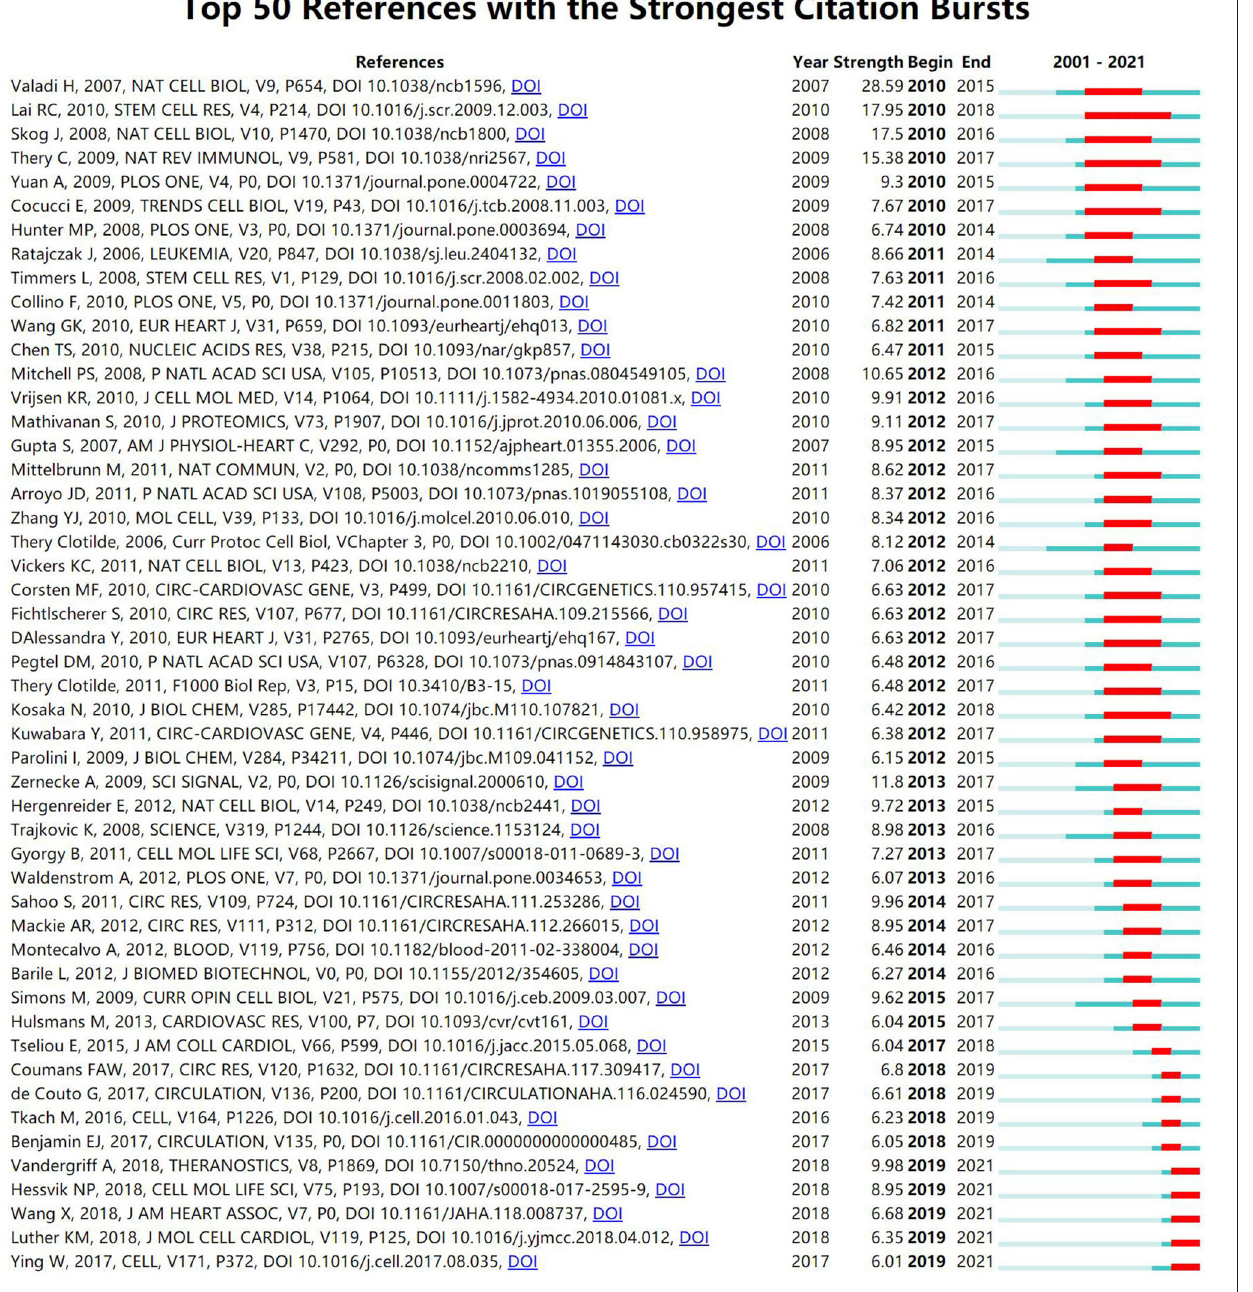
FIGURE 8 | CiteSpace visualization map of top 50 references with the strongest citation bursts involved in exosomes in